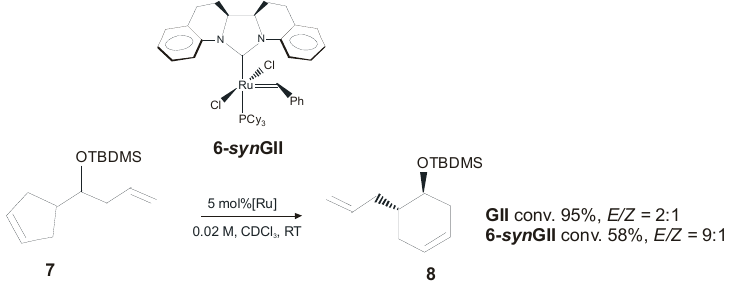
Figure 5. Diastereoselective RRM of 7 with catalyst 6- syn GII.